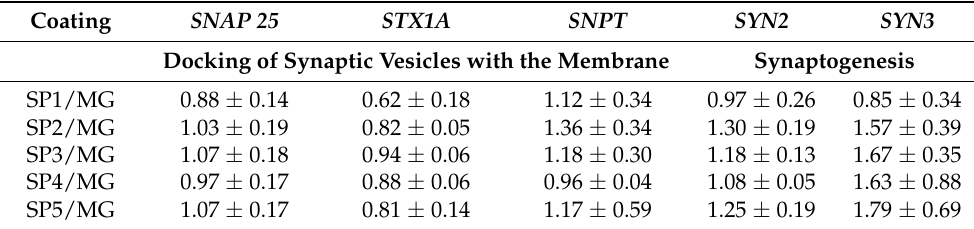
Table 2. Relation of the synapse-specific gene transcription levels in NPCs cultivated on CCs com- pared with MG.